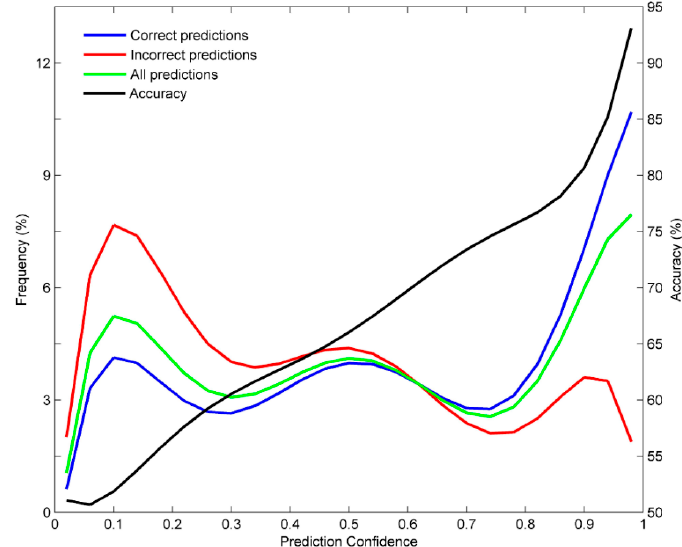
Figure 3. Distributions of the 1000 prediction accuracy values calculated from the DF models in permuation tests (red line) and yielded from the DF models in the cross validations (blue line). Prediction accuracy was calculated for the predictions in each of the 20 groups. The numbers of predictions, correct predictions and incorrect predictions for the 20 groups were shown as blue, red and green distribution curves respectively in Figure 4.